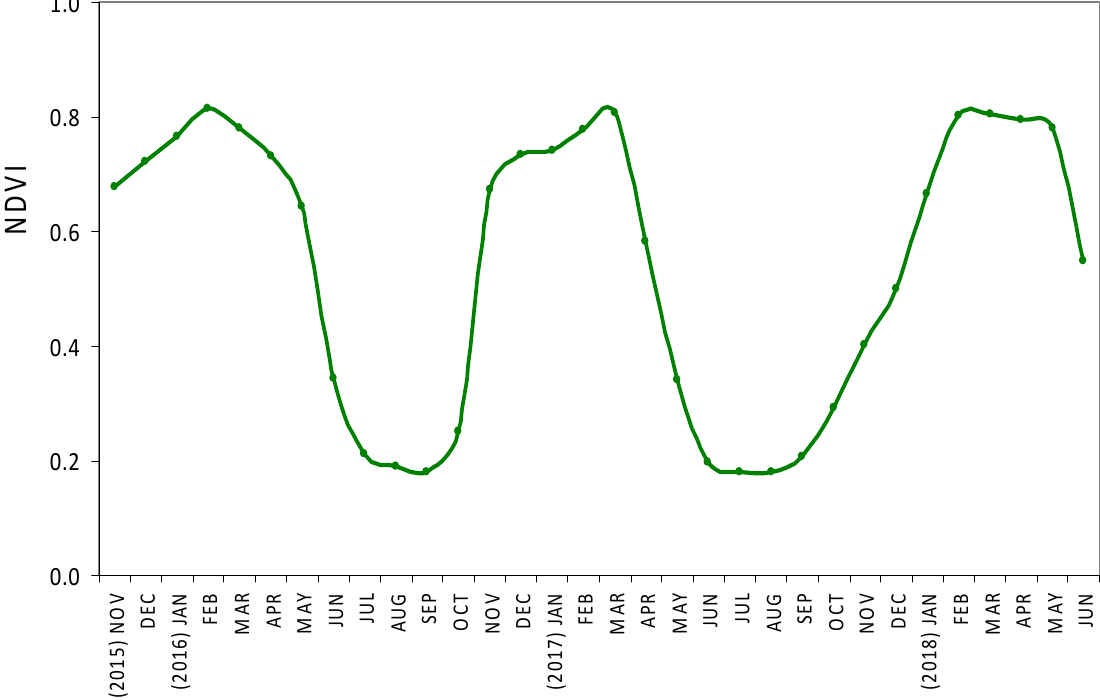
Figure 4. Evolution of mean normalized difference vegetation index (NDVI) at experimental field between November 2015 and June 2018.